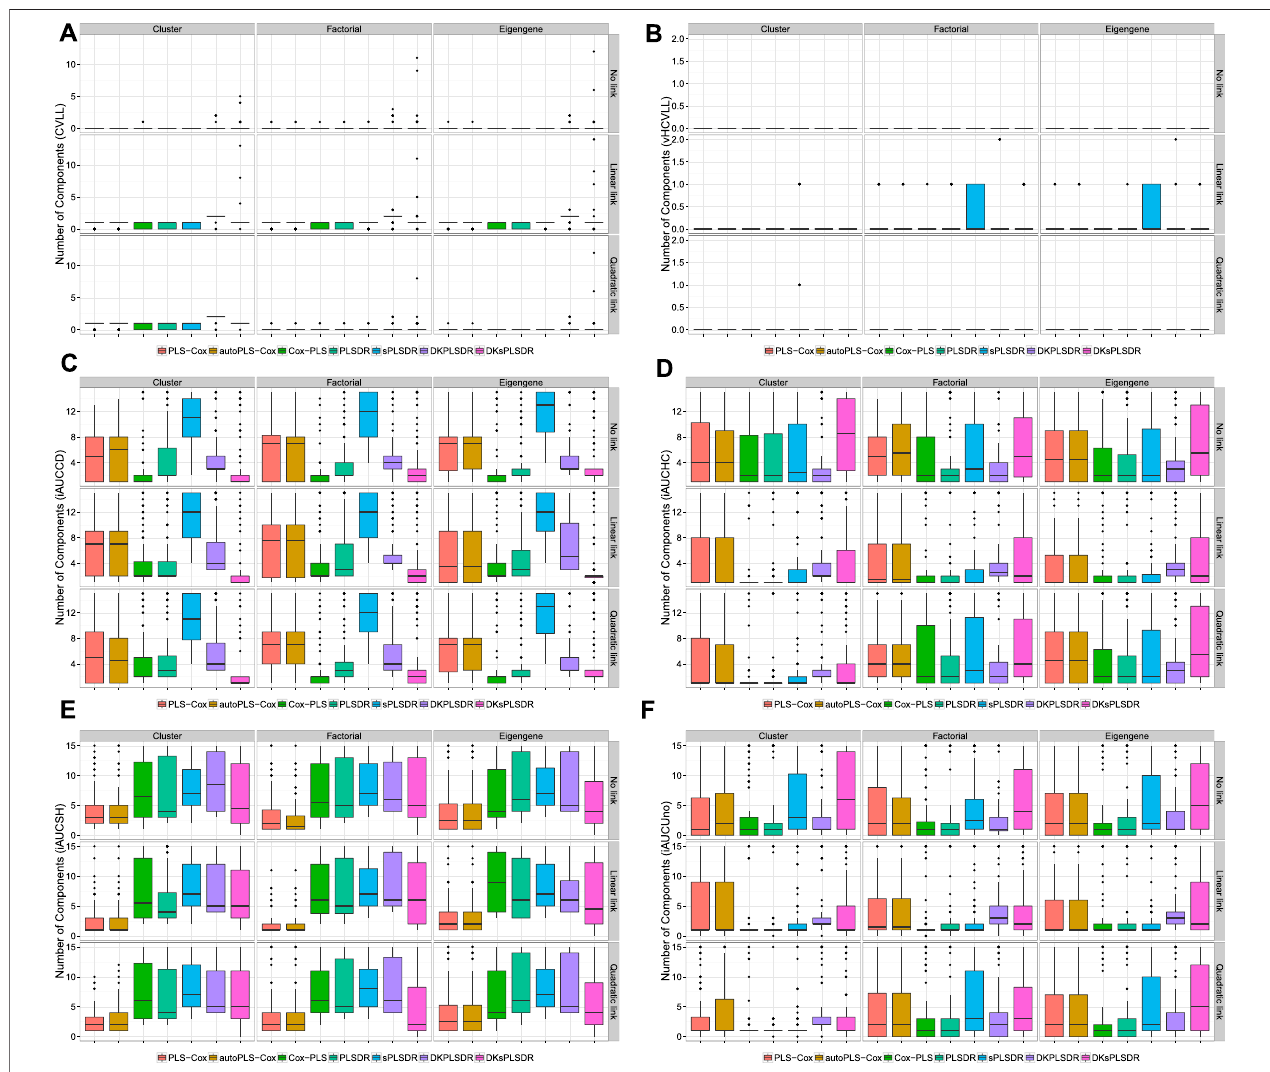
FIGURE 1 | Number of components. panel (A) : LL criterion. panel (B) : vHLL criterion. panel (C) : iAUCCD criterion. panel (D) : iAUCHC criterion. panel (E) : iAUCSH criterion. panel (F) : iAUCUno criterion.